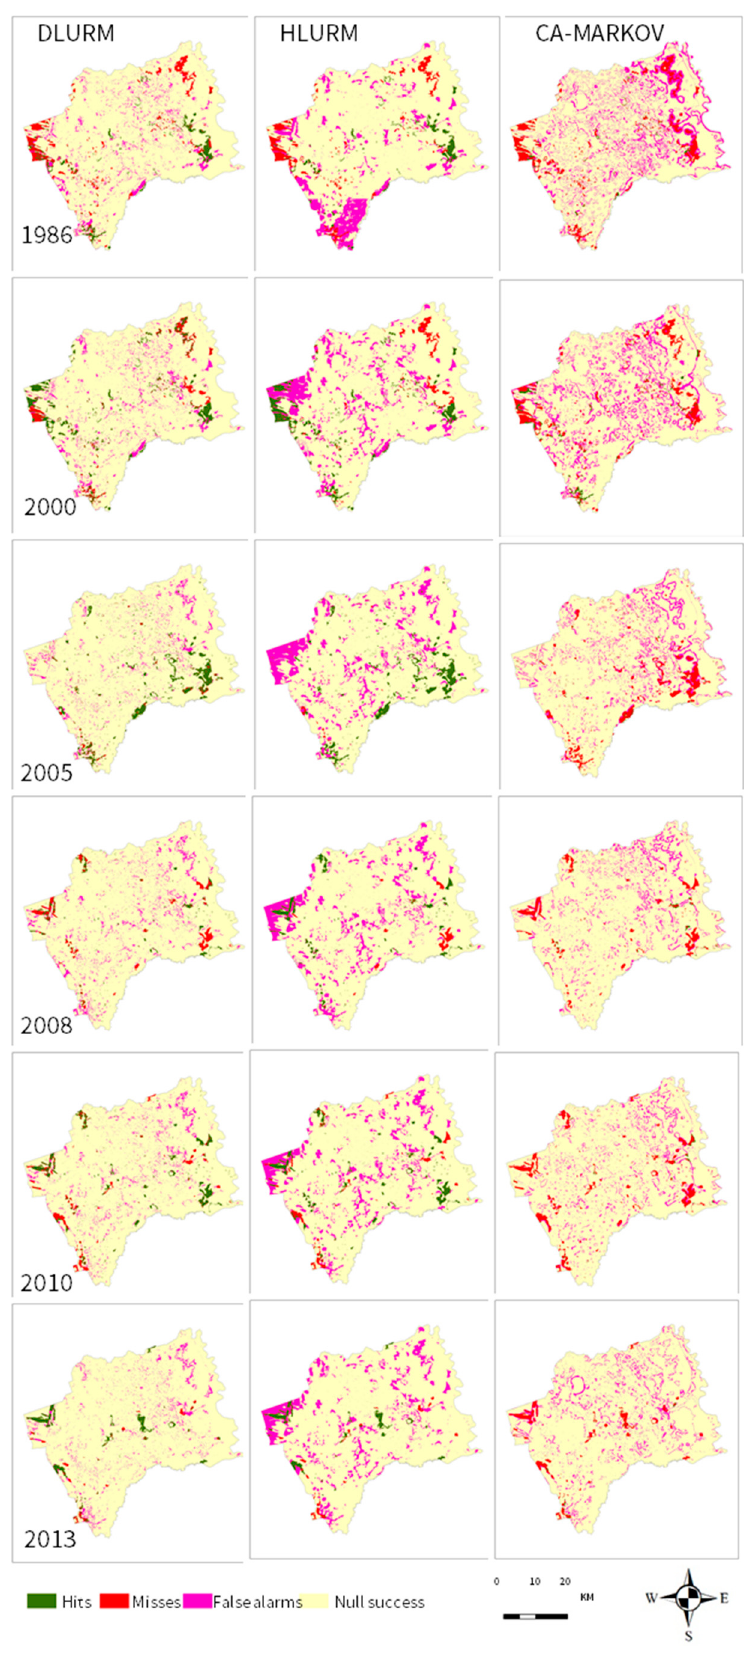
Figure 11. Prediction correctness and error.